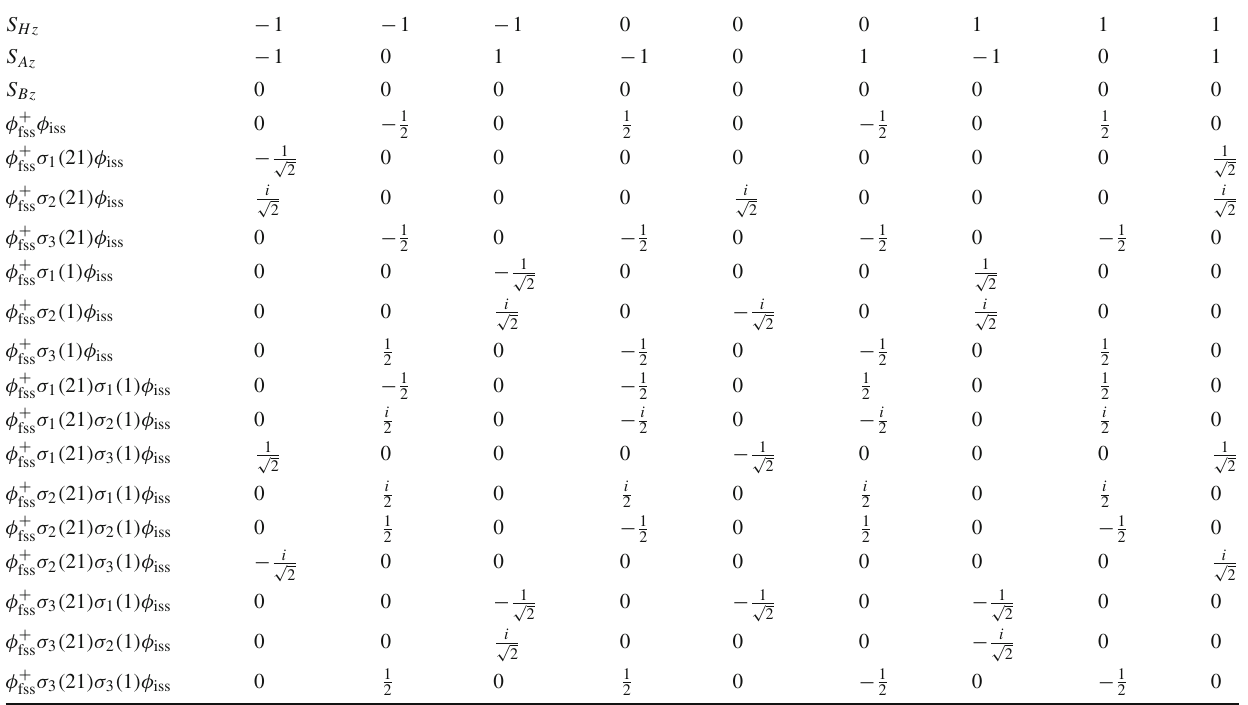
for A ( S A = 1 ) + B ( S B = 0 ) → H ( S H = 1 ) 1 ¯ q 2 ¯ q 1